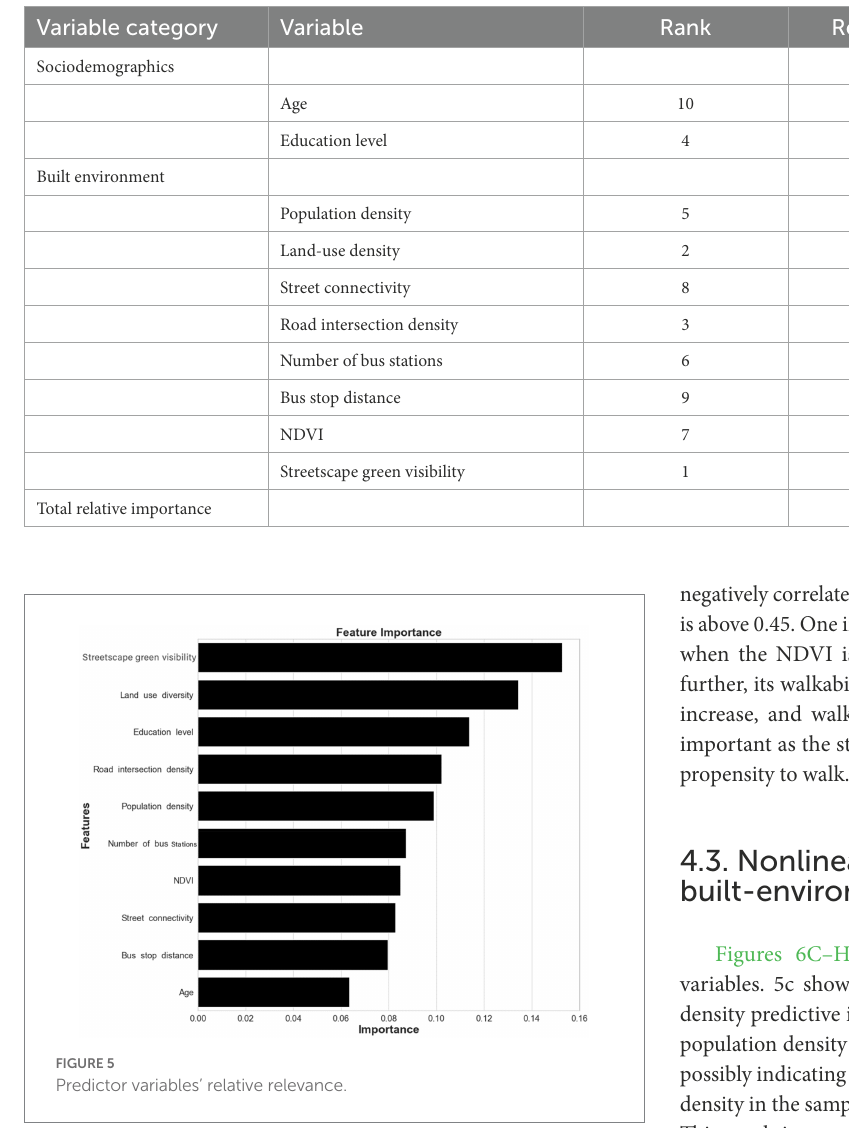
TABLE 4 The random forest algorithm calculates the relative relevance of predictor variables.